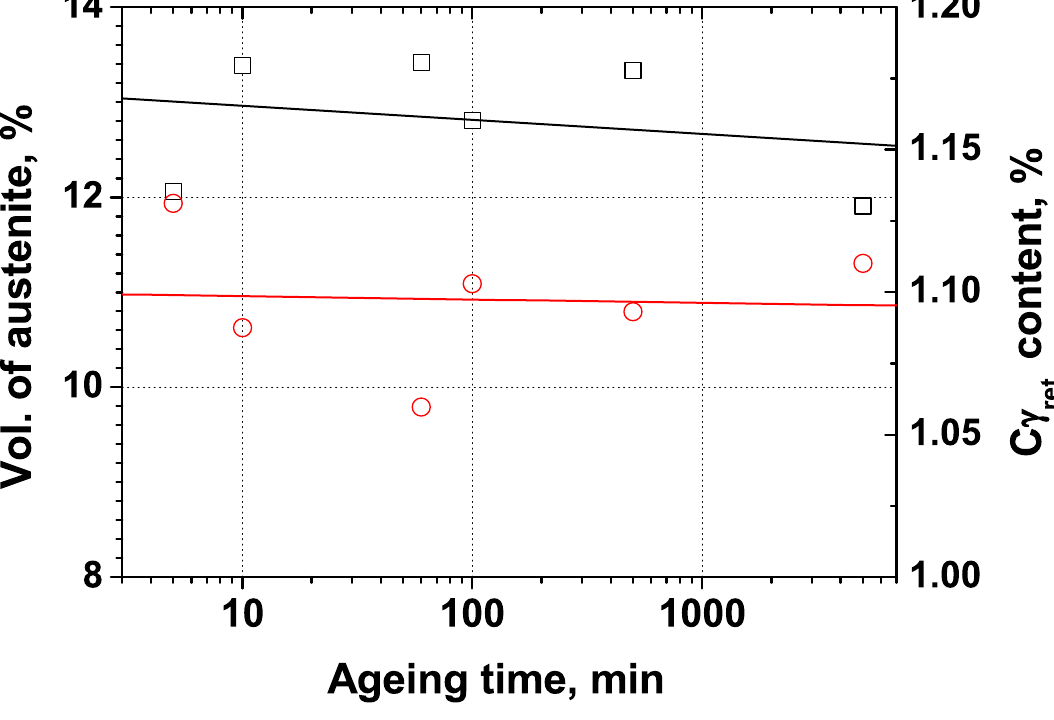
Figure 15. Evolution of the carbon content and volume fraction of retained austenite by means of XRD for the TRIP5 steel after aging at 170 ◦ C for 5, 10, 60, 500, and 5000